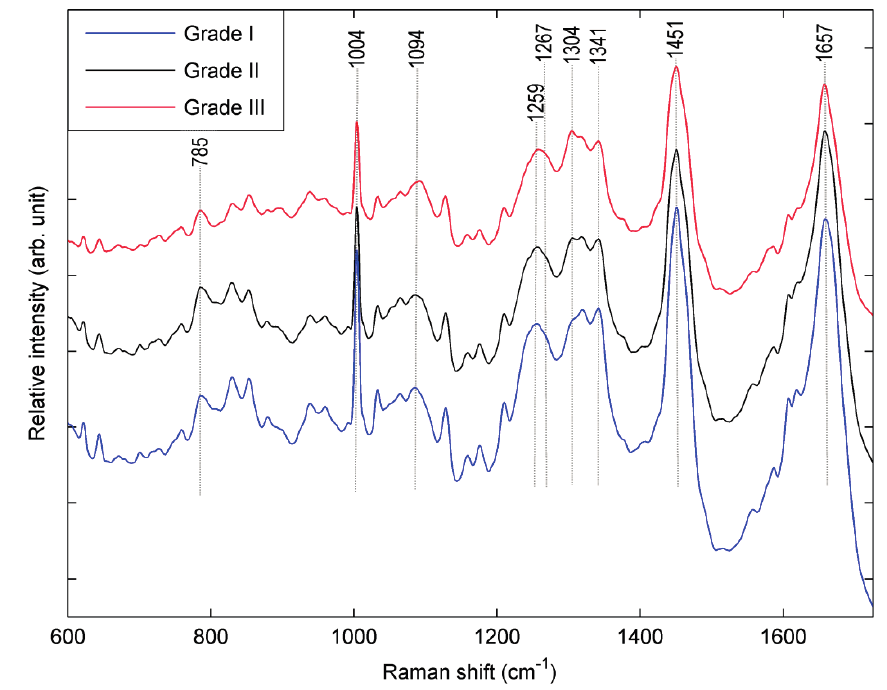
Figure 1. Normalized mean ( n = 150) Raman spectra of chondrocytes which were isolated from osteoarthritic cartilage of ICRS Grade-I, II and III. Spectra are vertically offset for